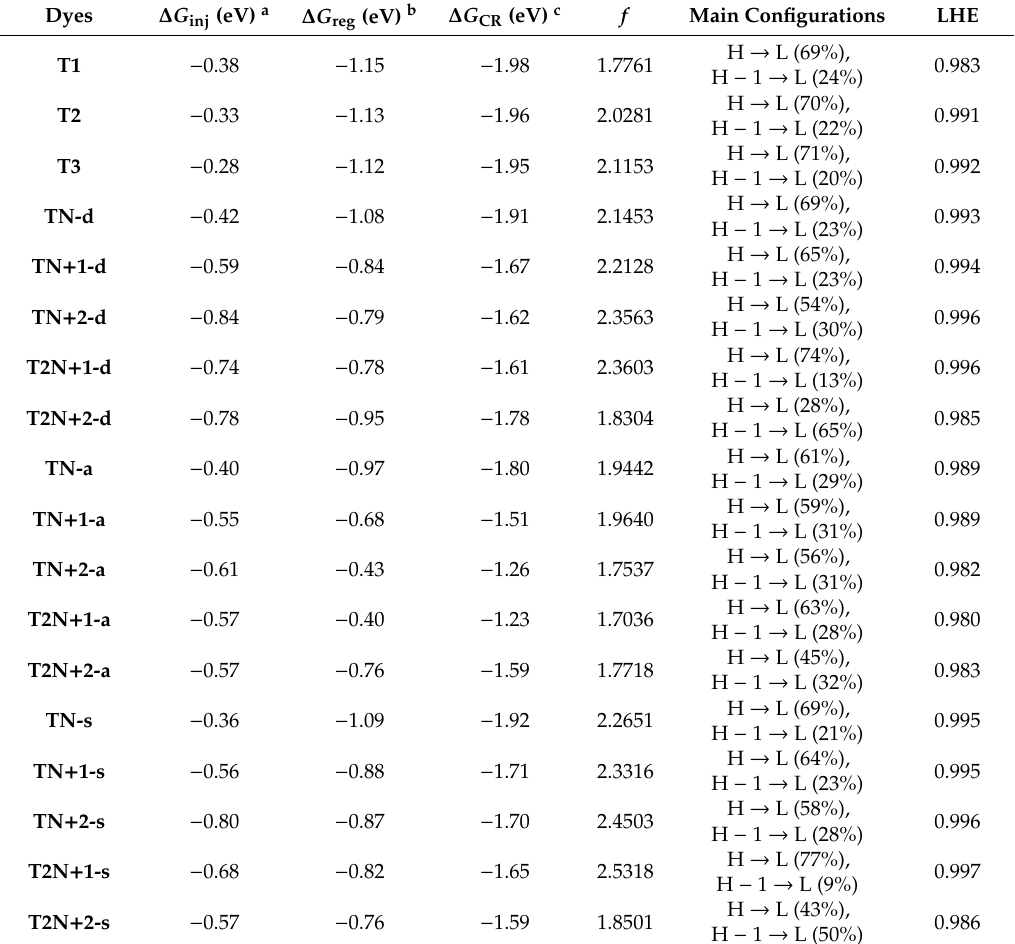
Table 2. Computed ∆ G inj , ∆ G reg , ∆ G CR , transition configuration and LHE of the